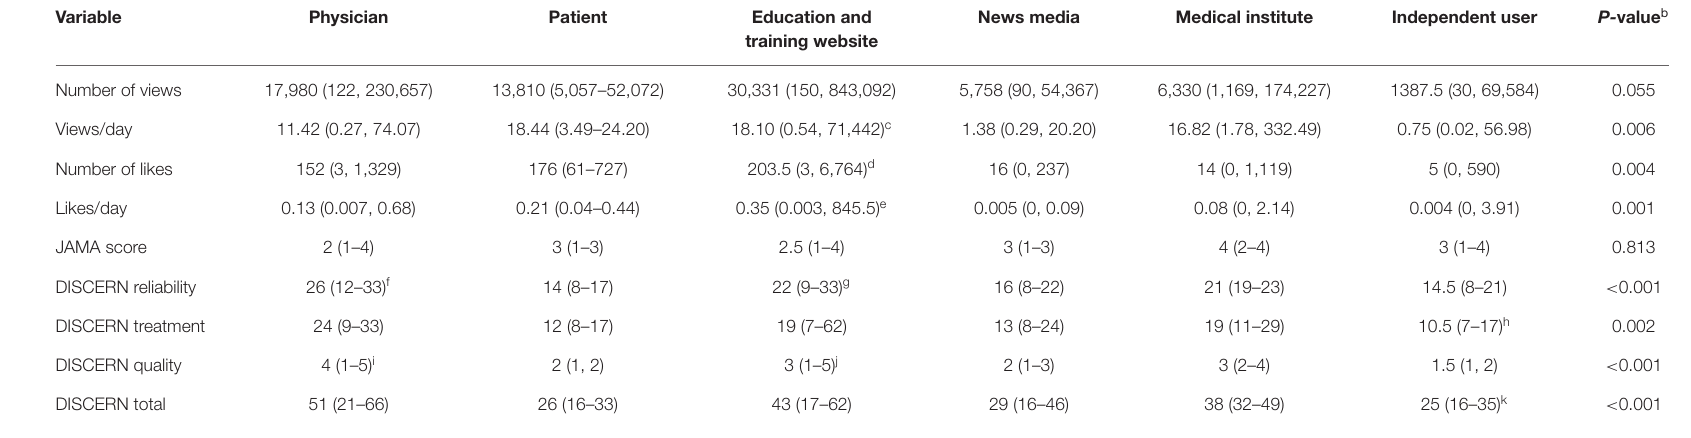
TABLE 4 | Video features and quality assessments according to the video source a